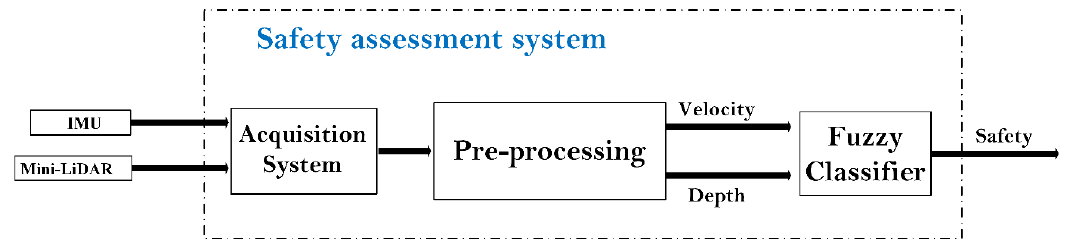
Figure 5. Safety assessment system using sensor data fusion and fuzzy classifier.